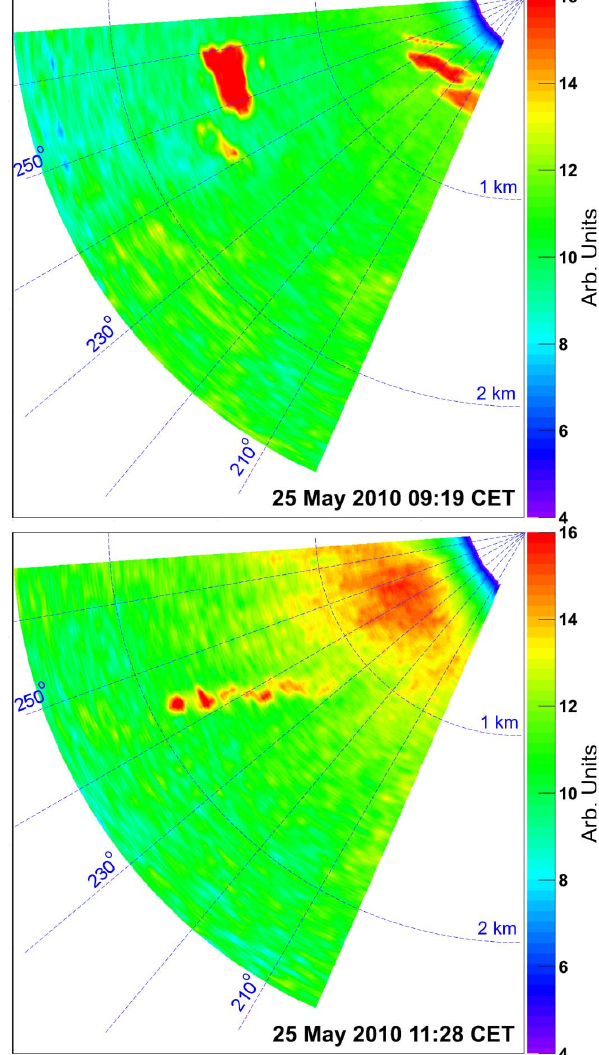
Fig. 5. Two examples of horizontal PPI sector scans showing the logarithm of the range-corrected LIDAR signal (performed at 09:19 and 11:28CET on 25 May 2010) show localized increases of LI- DAR return corresponding to aerosol emission sources (B) and (D). In the later scan, the dispersion of the plume (D) towards the NE due to the increased wind speed can be clearly